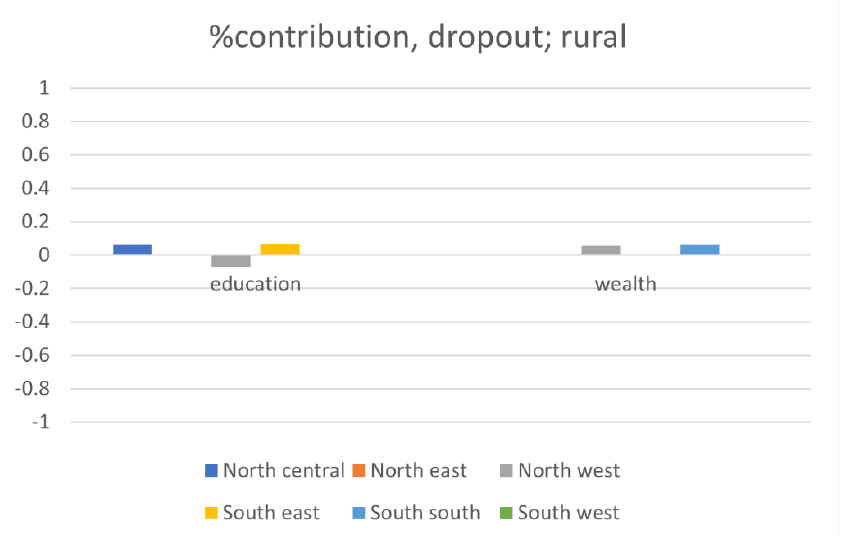
Figure 4. Contributions of the improvements in education and wealth to the reduction in the number of children with incomplete vaccination status by zone.